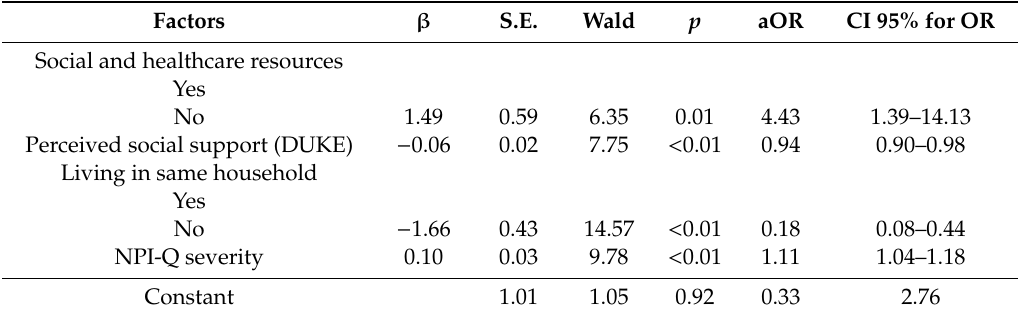
Table 6. Predictors of perceived health amongst middle-stage family caregivers: Multivariate logistic regression. Factors β S.E. Wald p aOR CI 95% for OR Social and healthcare resources Yes No 1.49 0.59 6.35 0.01 4.43 1.39–14.13 Perceived social support (DUKE) − 0.06 0.02 7.75 < 0.01 0.94 0.90–0.98 Living in same household Yes No − 1.66 0.43 Constant 1.01 0.92